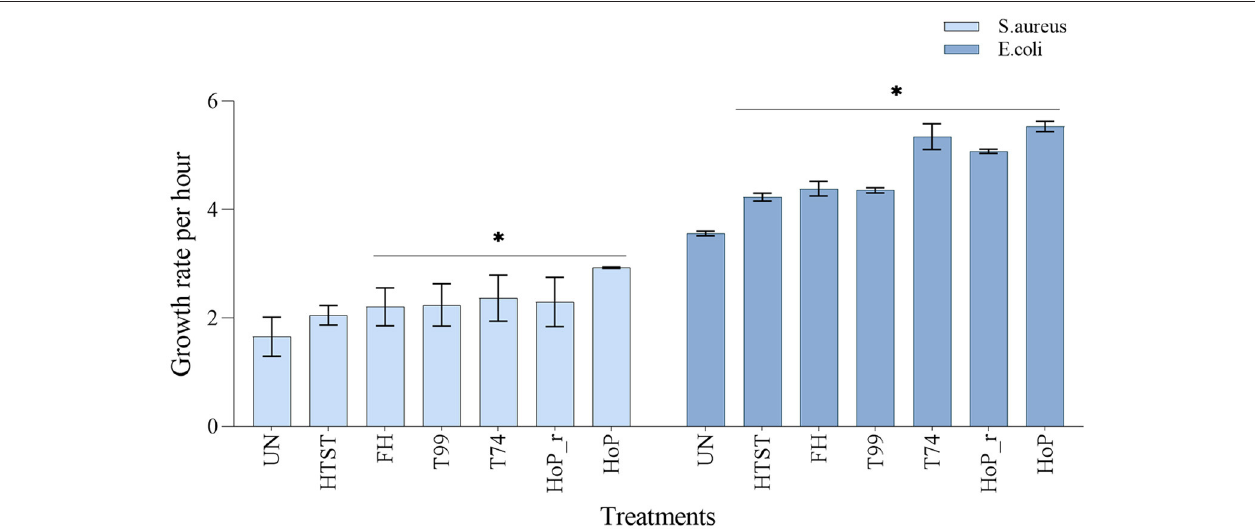
FIGURE 7 | Growth rate per hour of S. aureus and E. coli in untreated DHM samples and after HTST, FH, T99, HoP_r, T74 and HoP. The analyses were performed in duplicate for each sample and all values are presented as mean ± standard deviation of two independent experiments. *Expresses statistically significant differences to untreated samples ( p < 0.05). UN, HTST, FH, T99, T74, HoP and HoP_r stand for untreated DHM, and DHM treated with high-temperature short-time, flash heating, high-temperature short-time with a thermomixer preheated at 99 ◦ C, high-temperature short-time with a thermomixer preheated at 74 ◦ C, holder pasteurization and holder pasteurization with rapid heating up-times, respectively.